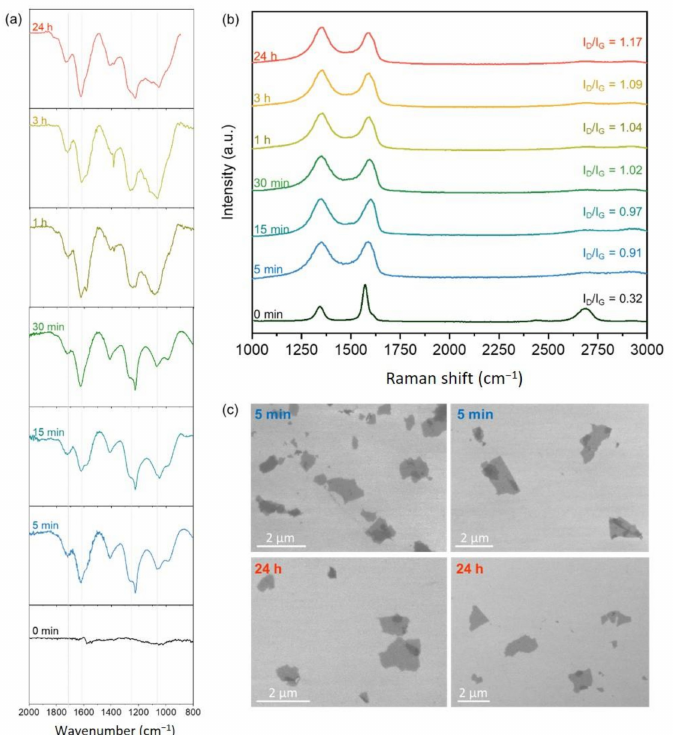
Figure 3. Characterization of graphene and GO obtained directly from the oxidation of graphene. ( a ) FTIR and ( b ) Raman spectra for different periods of oxidation. ( c ) SEM images comparing 5 min and 24 h of oxidation